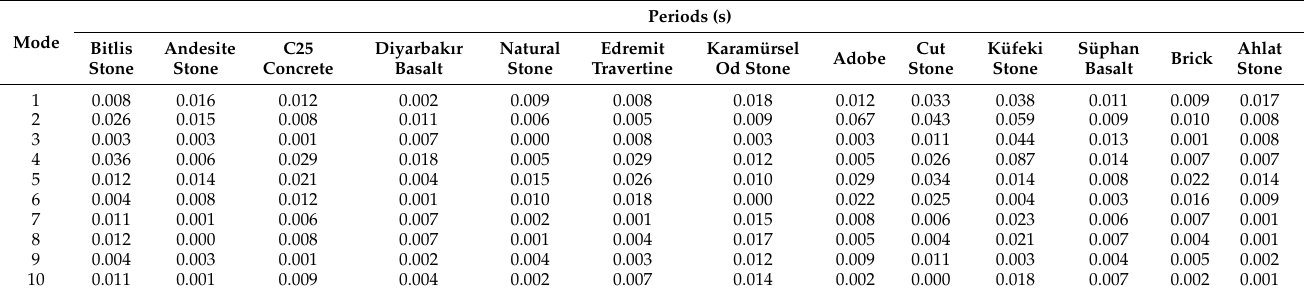
Table 12. Absolute error values of ANN for each mode and material